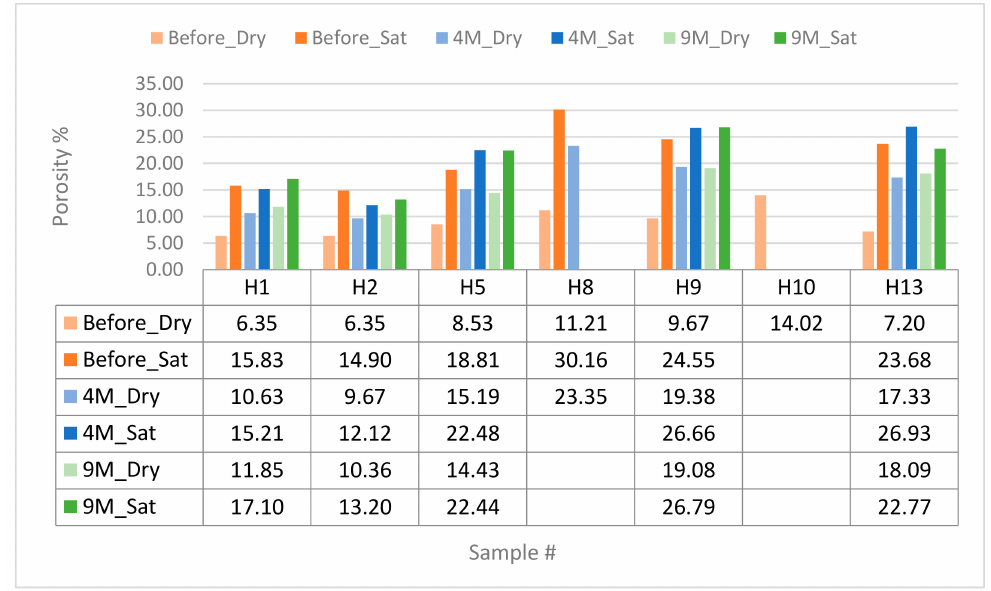
Figure 2. A comparison of porosities for samples before and after exposure to scCO 2